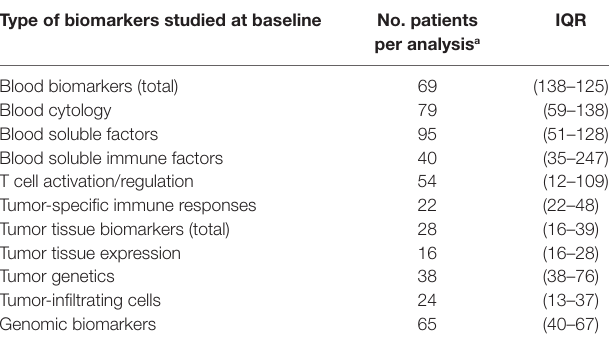
taBLe 1 | Study population size per biomarker category.